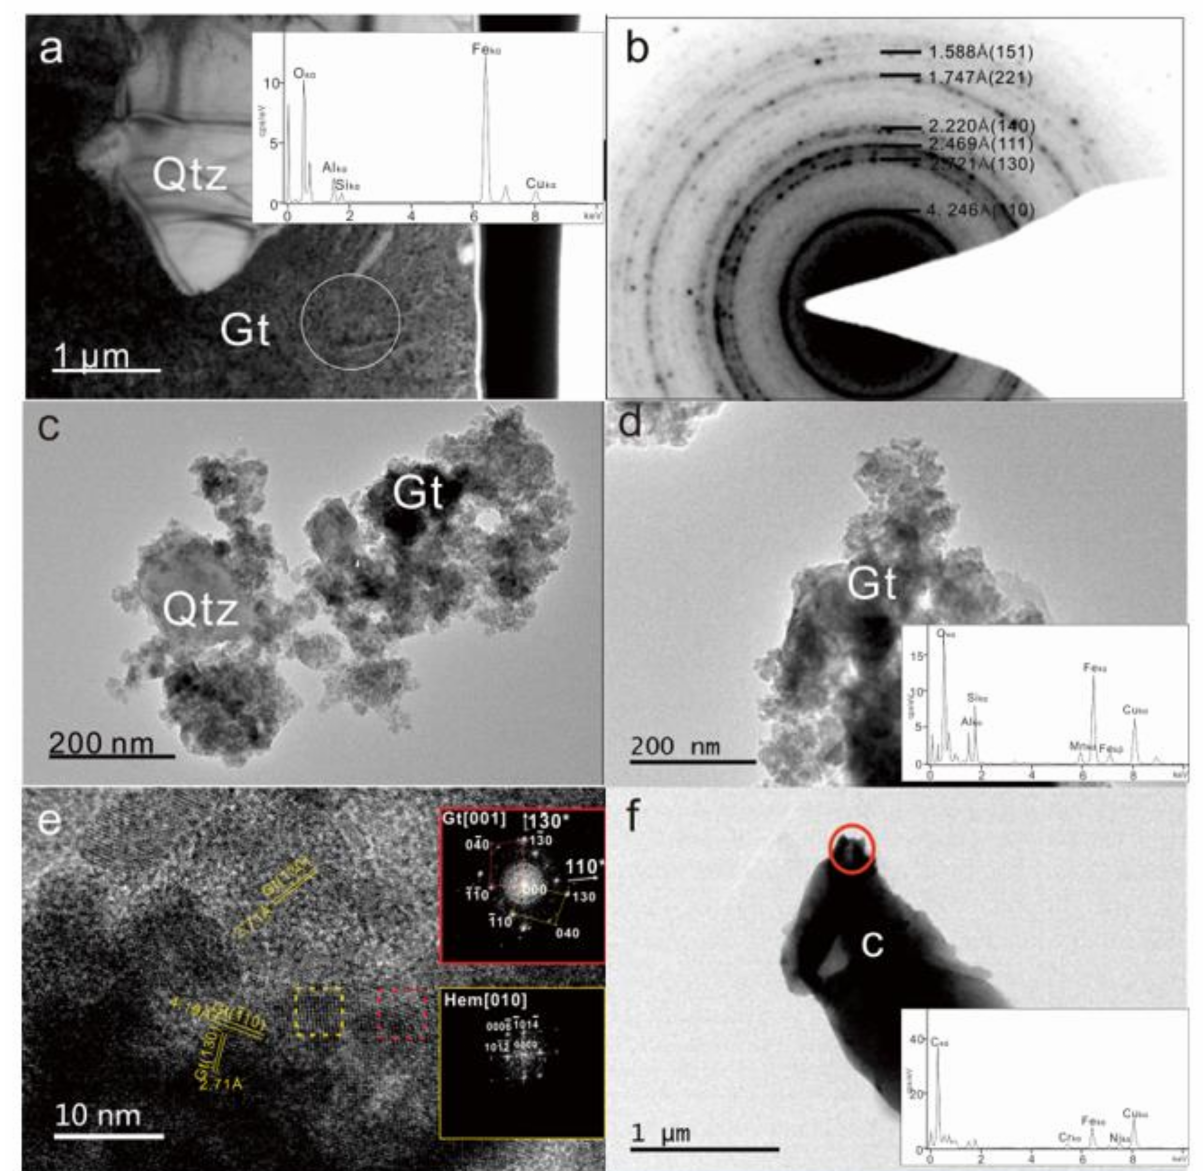
Figure 8. TEM images of iron-rich spherules. ( a ) Bright-field (BF) FIB-TEM image of PT09 sample showing quartz grain and goethite microcrystalline aggregations. TEM-EDS profile inserted in lower right corner is collected by using electron beam of spot size of 500 nm shown as a circle at bottom right of the image. ( b ) SAED ring pattern of PT09 TEM sample collected from goethite aggregation showing the D-spacing values for each ring which match goethite; the numbers on the left are the measured D-spacing values, and numbers in brackets are the planes indexed. ( c ) BF TEM images of powder TEM sample of PT02-02 showing quartz grain and goethite aggregations. ( d ) BF TEM images of powder TEM sample of PT02-04. TEM EDS profile is inserted in the lower right corner, which was collected from the center upper edge area less than 100 nm in diameter. ( e ) High-resolution TEM images of center upper edge region in Figure 8d showing lattice fringes of goethite and hematite crystals. Inserted image in upper right corner is a reduced forward Fourier transformation (FFT) image obtained from red dotted square area showing goethite [001] zone axis. Inserted lower right image is FFT image from yellow dotted square area showing hematite [010] zone axis. ( f ) BF TEM images of powder TEM sample of PT02 showing a carbon chip containing Fe-Ni-Cr alloy in upper right corner of the chip. TEM-EDS profile is inserted in the lower right corner showing certain amount of Fe-Ni-Cr in a C background. Gt = goethite, Qtz = quartz, Hem = hematite. The SAED of the PT09 sample shows a diffraction ring pattern (Figure 8b). D-spacing values and brightness intensities of each ring are consistent with the goethite XRD